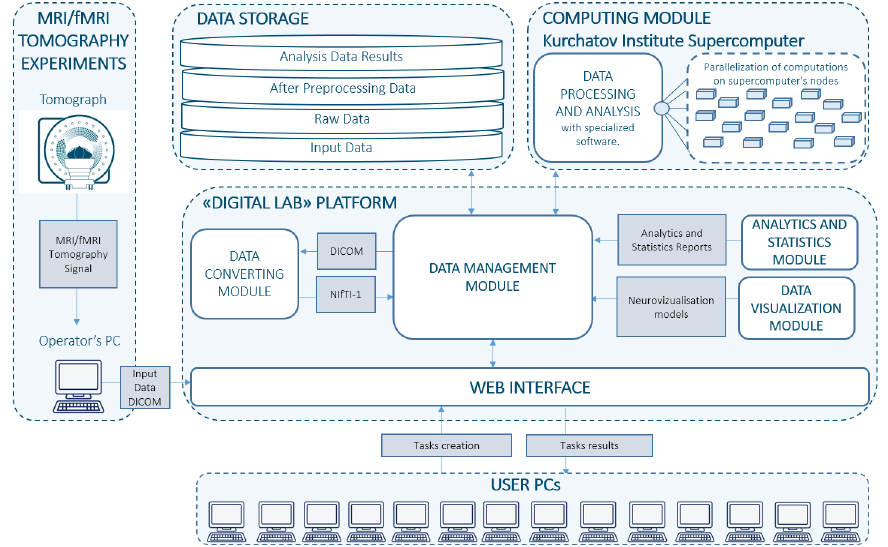
Figure 2. (Color online) Computer model of the System for Automatic Processing and Analysis of MRI / fMRI data.